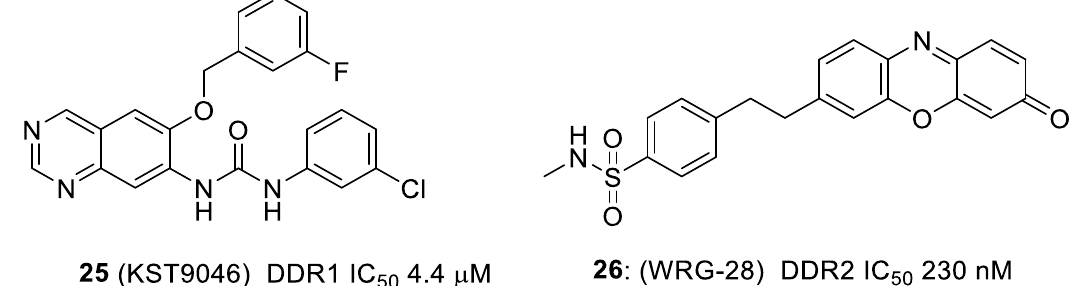
Figure 5. Allosteric DDR inhibitors.